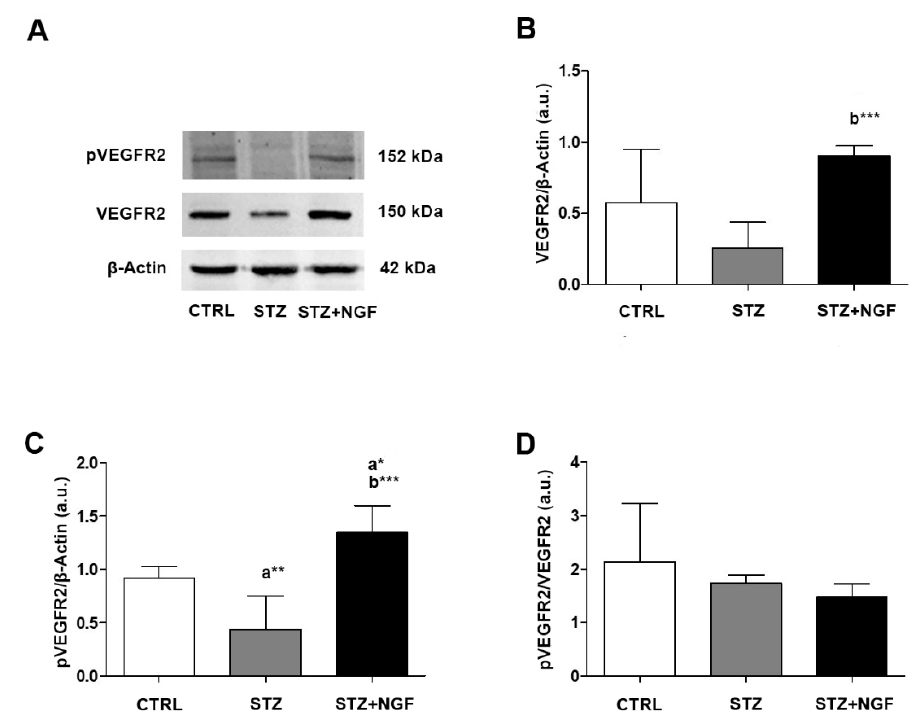
Figure 3. ( A – D ). VEGFR2 and its phosphorylated status (pVEGFR2) levels in diabetic rat retina, before and after NGF ocular treatment. VEGFR2 and pVEGFR2 levels altered in STZ and STZ+NGF groups, as showed by Western Blot ( A ) and densitometric analyses ( B – D ). β -Actin expression was used to normalize sample variability, a.u. indicates arbitrary units. The results are expressed as mean ± SD. Statistical significance is indicated with * p < 0.05, ** p < 0.01, *** p < 0.001. “a” vs. CTRL group; “b” vs. STZ group. CTRL, healthy rats; STZ, streptozotocin; STZ+NGF, streptozotocin+nerve growth factor eye drops.